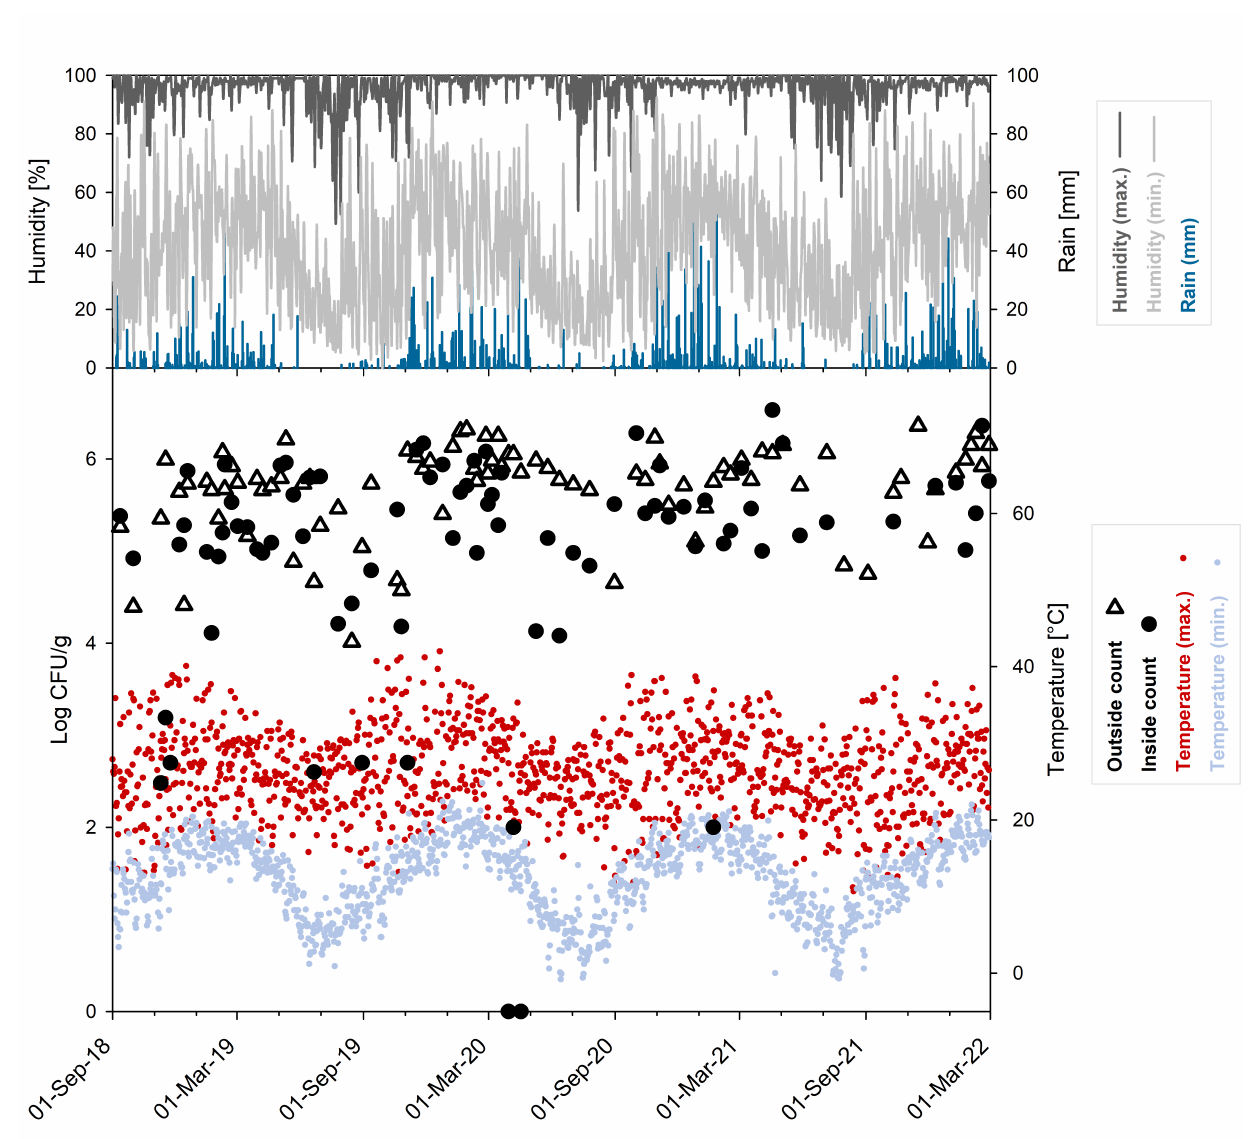
Figure 3. Daily climate data (rain, humidity and temperature) and average viable Basidiobolus spp. counts (indoor and outdoor) observed over 3.5 years of